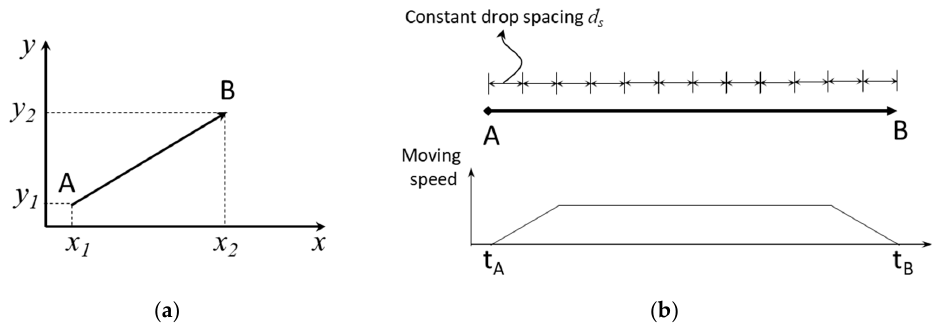
Figure 5. Vector printing using equally spaced distance. ( a ) Vector movement of 2 axes, and ( b ) equally spaced distance for vector printing.